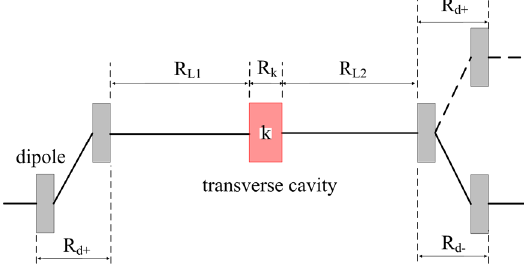
FIG. 1. Emittance exchange beam line based on a chicane and two